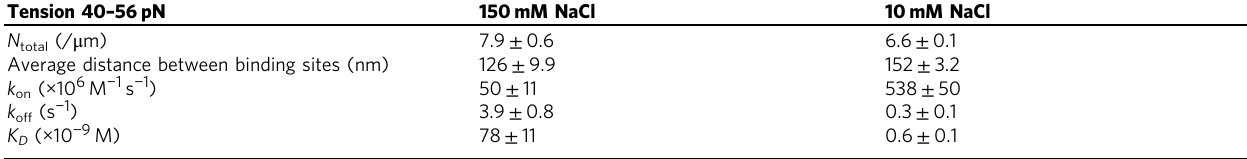
(a) Tabulation of data from Fig. 3f. (b) Combined results of fi tting all data from Fig. 3f in the two highest force bins ( > 40pN) where activation by force is maximal. The errors in the table are SD for tension and 95% con fi dence intervals for the other